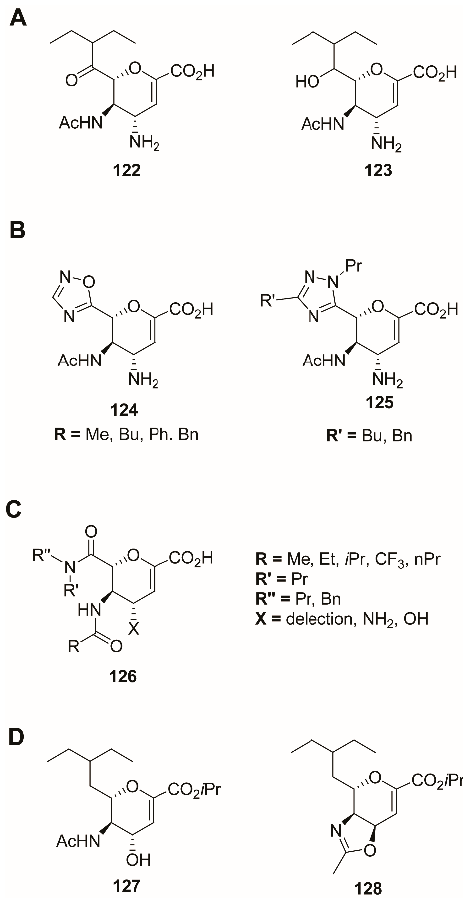
Figure 3. Complex zanamivir analogues. ( A ) Zanamivir analogues 122 and 123 synthetized by Smith and coworkers [74]; ( B ) Zanamivir analogues 124 and 125 synthetized by Smith and coworkers [75]; ( C ) Zanamivir analogue 126 synthetized by Wyatt and coworkers [76]; ( D ) Zanamivir analogues 127 and 128 synthetized by Beau and coworkers [77].